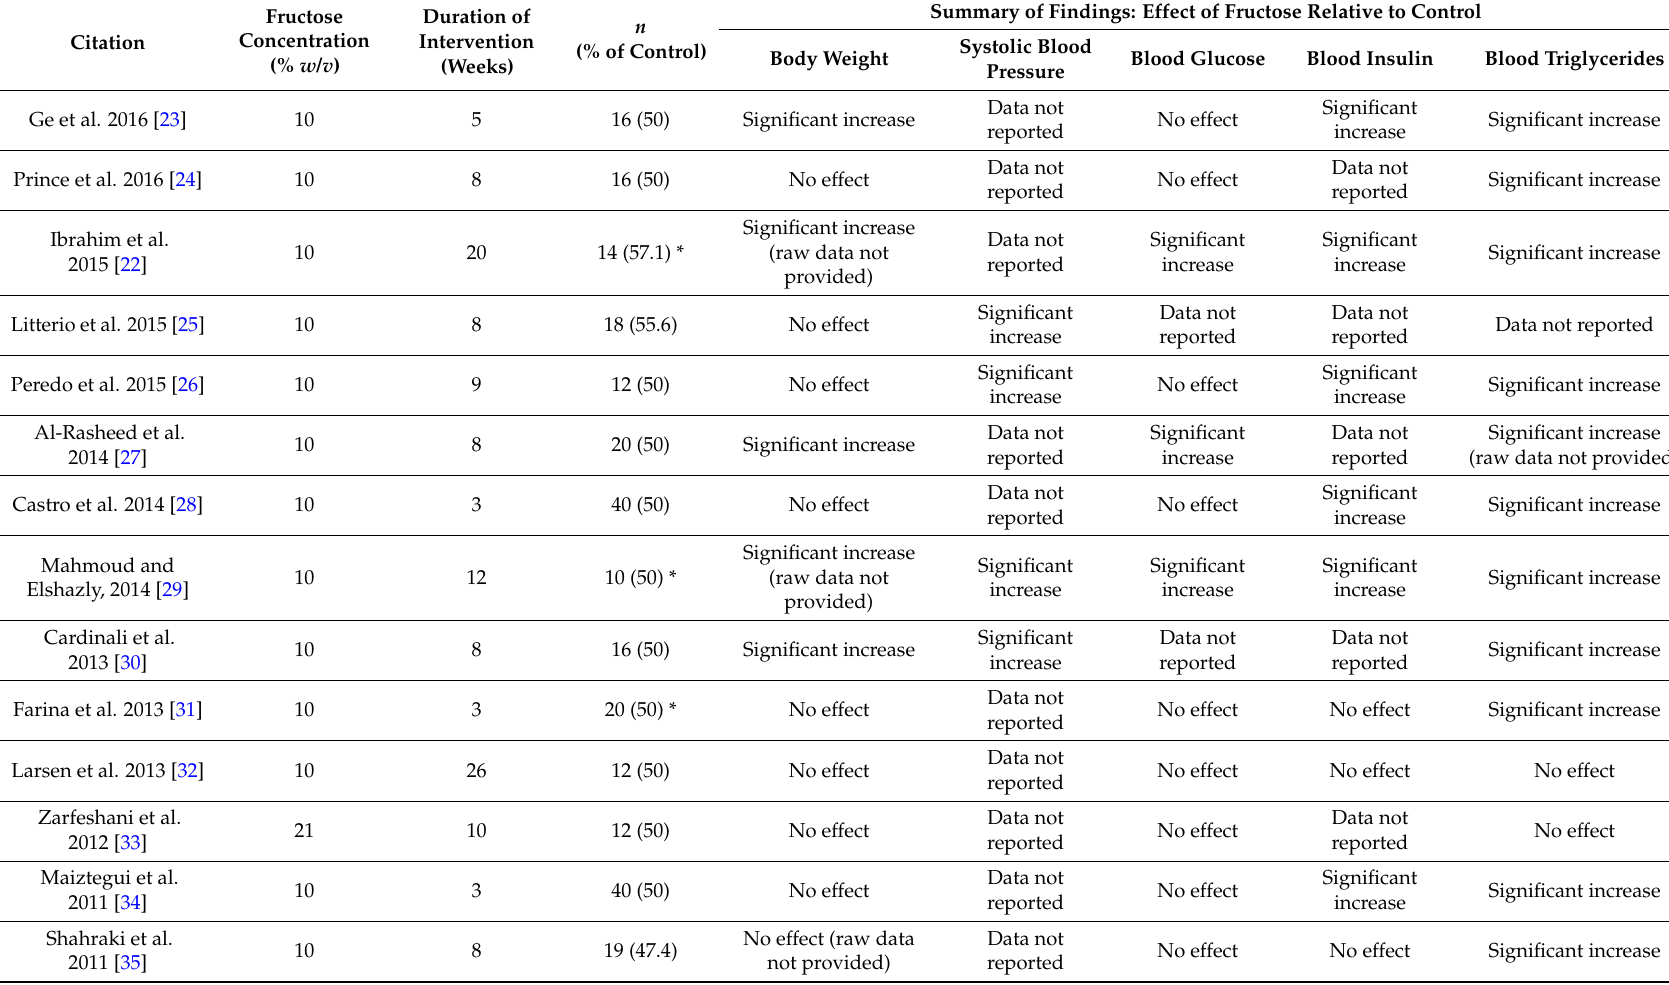
Table 1. Characteristics and major outcome measures of studies included in the meta-analysis, including the effects of fructose beverage consumption on male body weight, systolic blood pressure and blood glucose, insulin and triglyceride